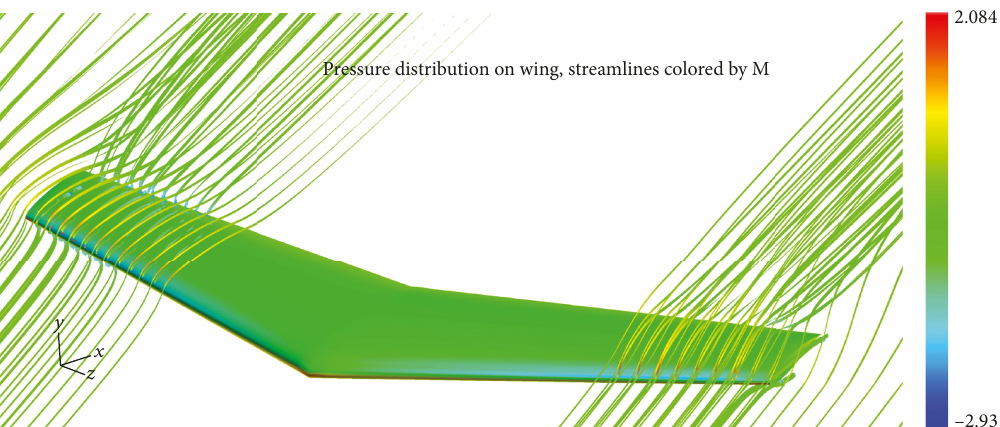
Figure 12: BGK wing under no side wind shear.